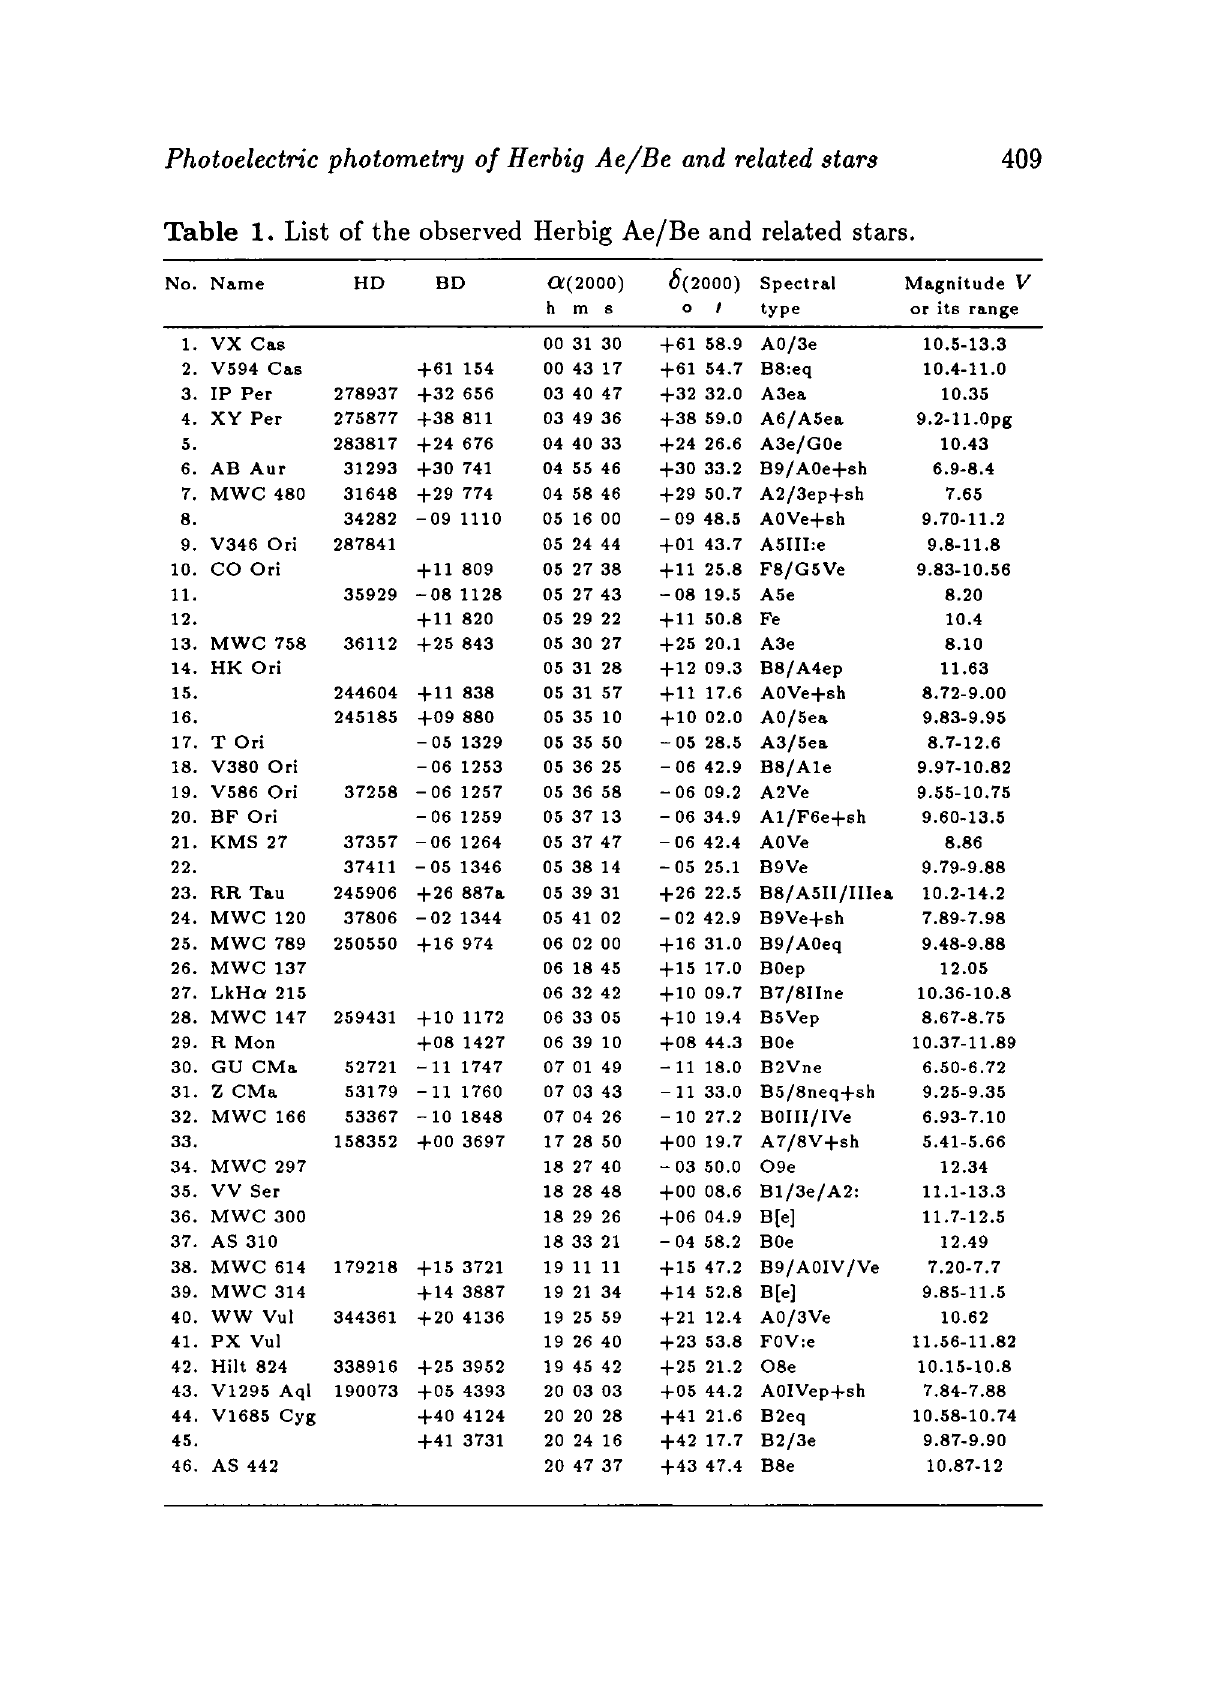
Table 1. List of the observed Herbig Ae/Be and related